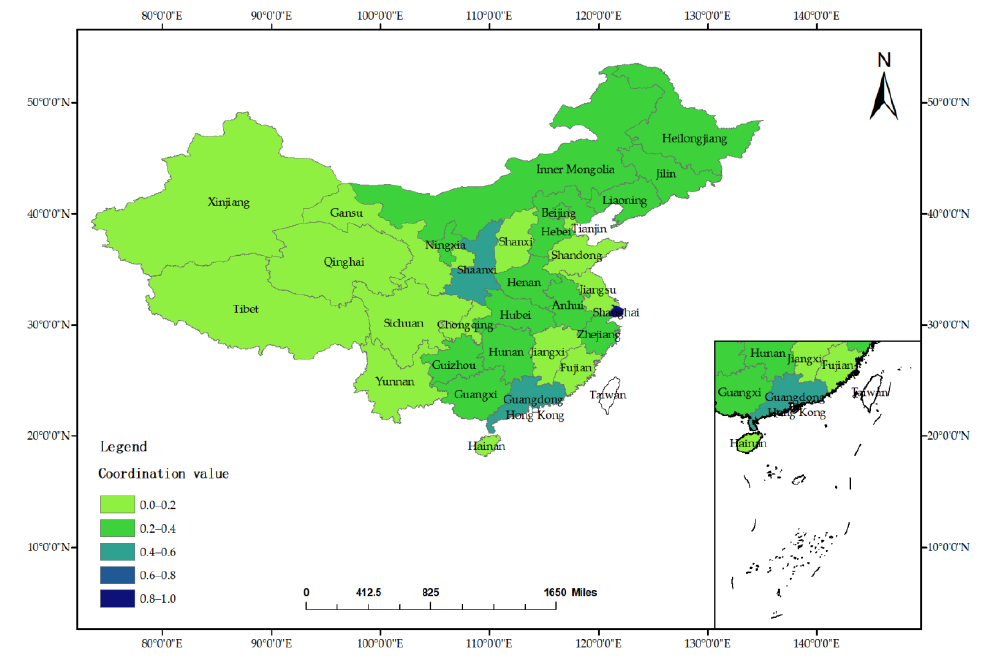
Figure 7. Distribution of the coordination degree in 2018.